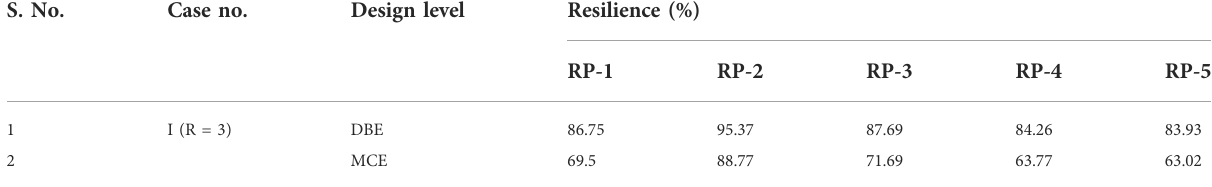
TABLE 9 Variation in resilience at each design level for case I